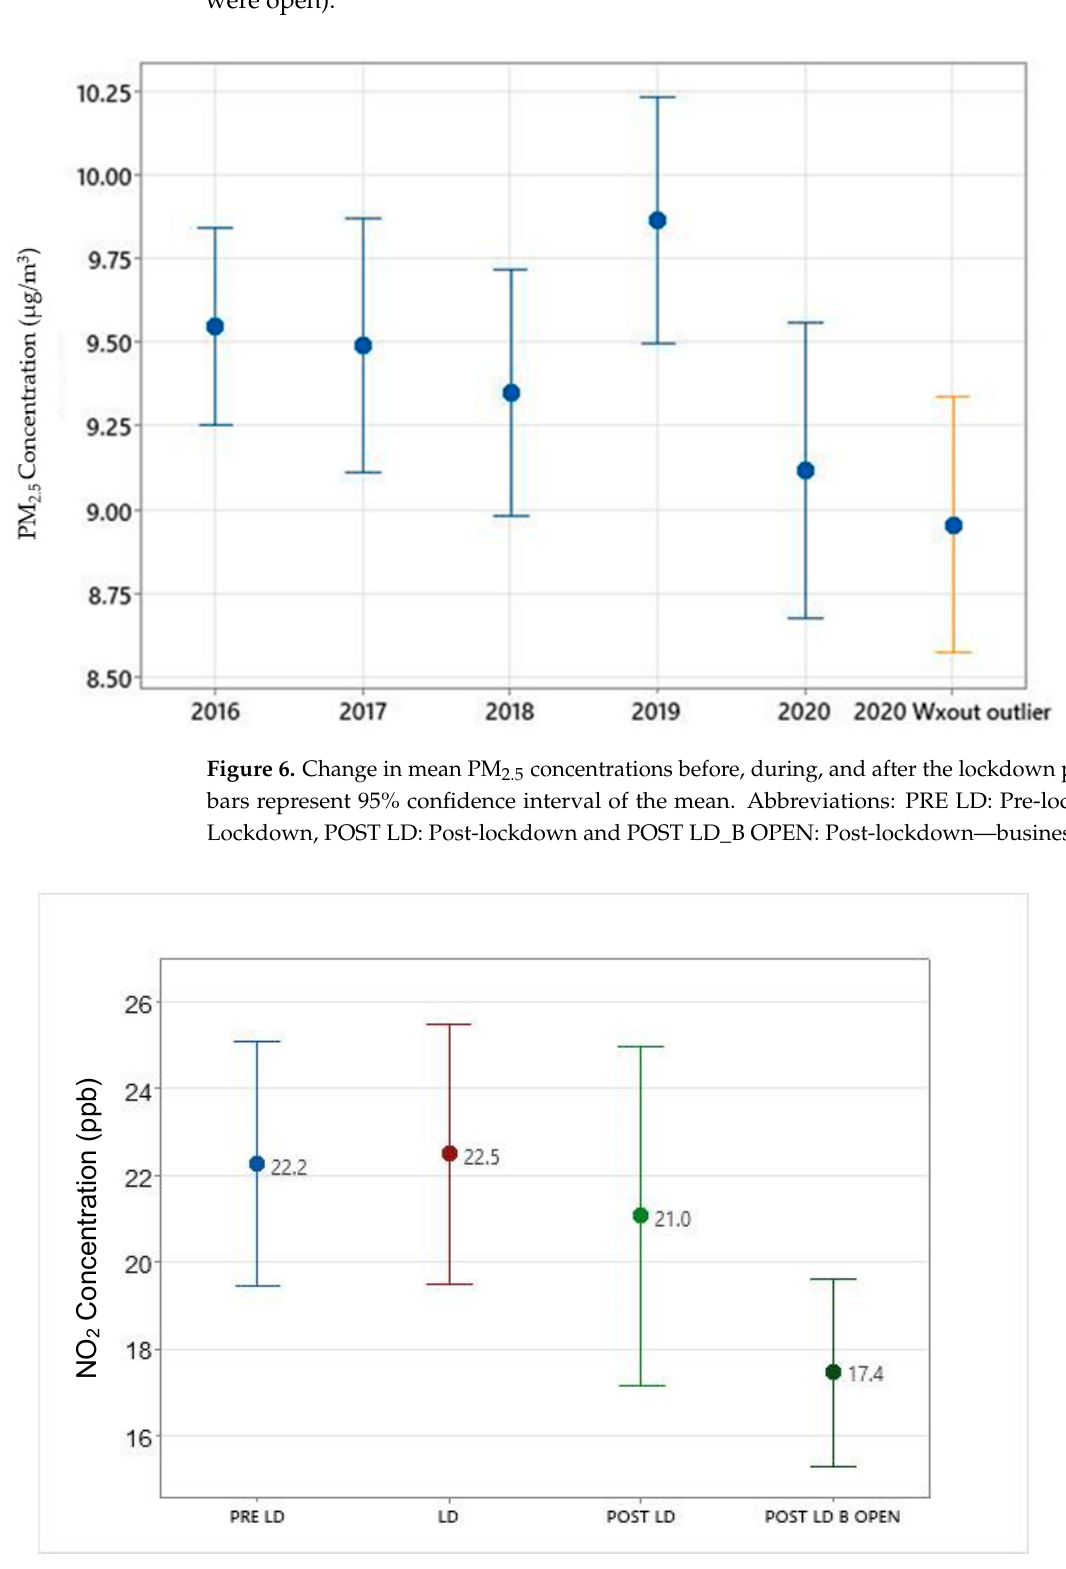
Figure 7. Change in mean NO 2 concentrations before, during, and after the lockdown period. Error bars represent 95% confidence interval of the mean. Abbreviations: PRE LD: Pre-lockdown, LD: Lockdown, POST LD: Post-lockdown and POST LD_B OPEN: Post-lockdown—businesses open.